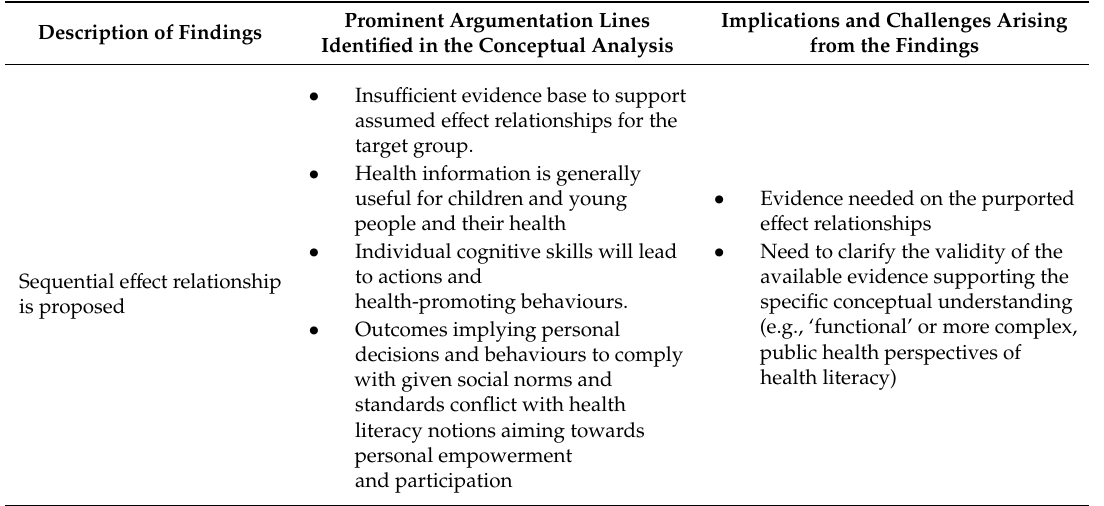
Table 6. Summary of conceptual reflections regarding the purpose and expected outcomes of health